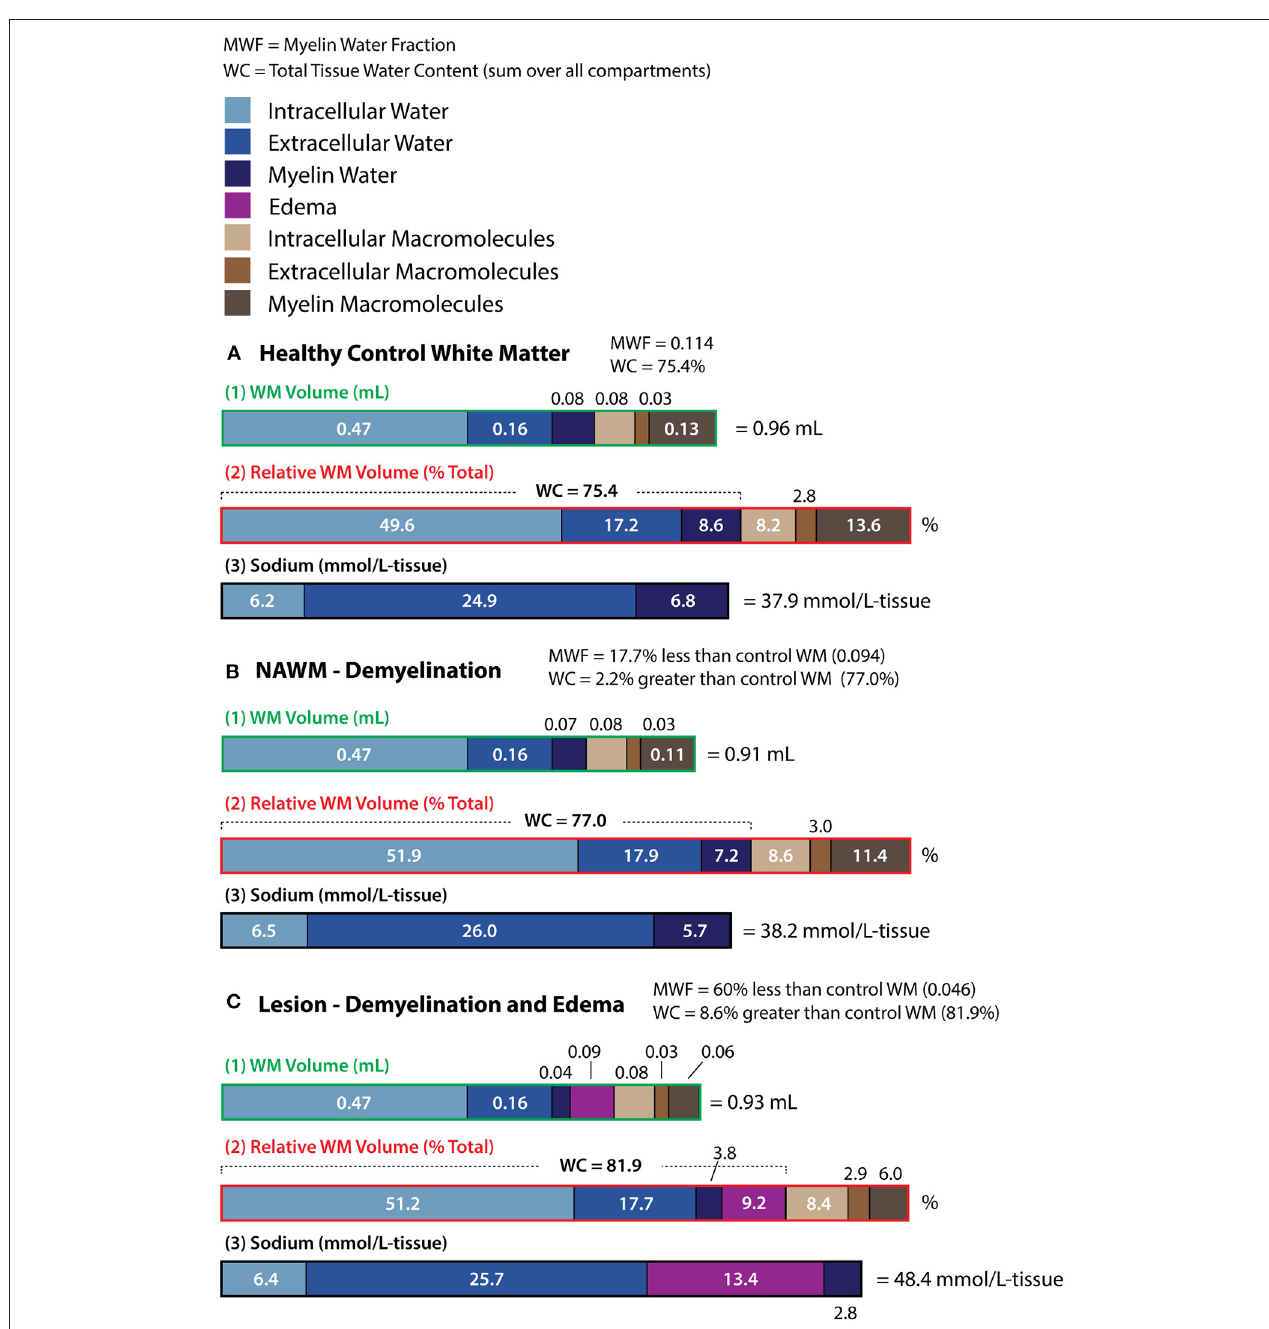
FIGURE 7 | Compartmental white matter (WM) volumes referenced to 1 gram of healthy tissue (label “1” and green), relative WM volumes as a percentage of total tissue volume (label “2” and red), and sodium concentrations (label “3” and black) are given for models of (A) healthy control white matter, (B) NAWM, and (C) lesions. Compartmental white matter (WM) volumes are based on myelin water fraction (MWF) for (A) healthy control white matter, and both MWF and water content (WC) difference from healthy control WM for (B) NAWM and (C) lesions. White matter volumes were calculated according to the T 2 study of MS in reference (29), and the volumes for both (A) and (B) are also presented in (29). For the lesion case (C) , both demyelination and edema are required to model MWF and WC difference values derived from (29). Note that for healthy control WM (A) , the myelin sodium concentration is as great as that of intracellular sodium. Demyelination reduces myelin sodium, but when the loss of myelin macromolecules is associated with tissue atrophy [4.3% for NAWM in (B) ], the relative fraction of space occupied by both intra- and extracellular sodium is increased (even if the absolute volumes of these spaces remain unchanged), slightly increasing tissue sodium concentration (in mmol/L tissue). For the lesion model (C) , considerably greater TSC is primarily driven by edema.